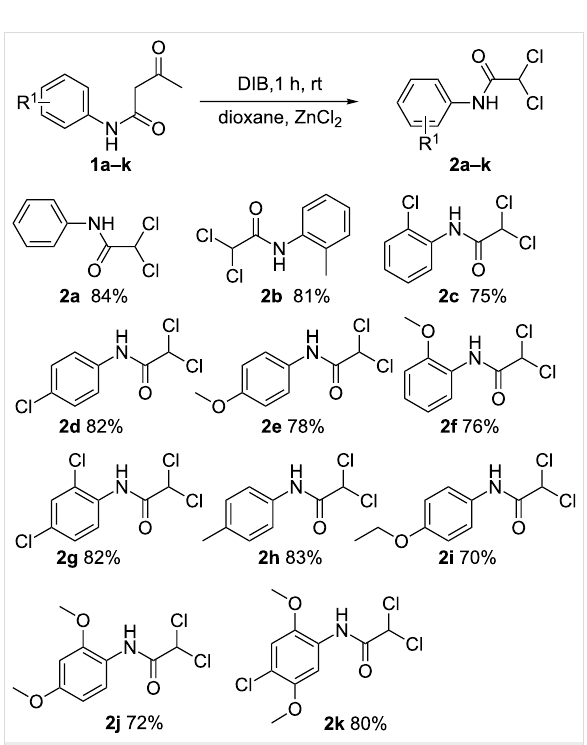
Scheme 3: Synthesis of dichloroacetamides. Reagents and condi- tions: 1 (1.0 mmol), dioxane (2 mL), DIB (1.3 equiv), ZnCl 2 (1.5 equiv); yields % are isolated